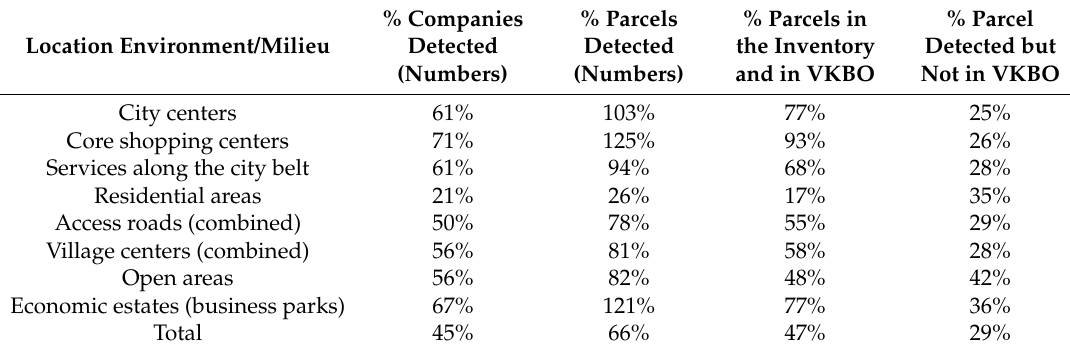
Table 4. Field inventory and